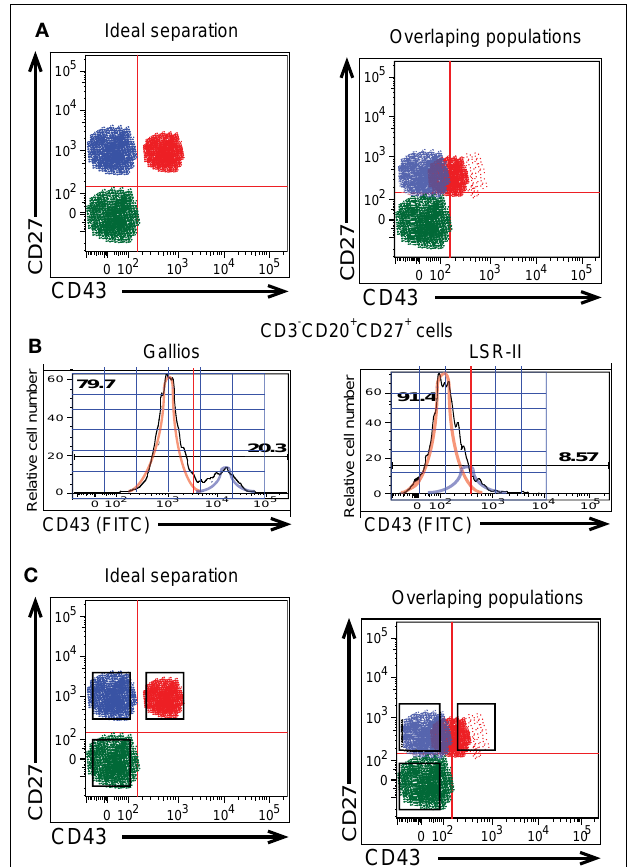
FIGURE 3 | Gating to distinguish positively and negatively stained B cells is difficult when populations overlap. (A) Diagrammatic models of ideal separation vs overlapping detection of CD43 + and CD43 − populations of CD27 + B cells are shown. (B) Adult peripheral blood mononuclear cells were immunofluorescently stained for CD20, CD27, CD43, and CD3, and were then evaluated by flow cytometric analysis. Expression of CD43 on CD3 − CD20 + CD27 + cells as detected by a BD LSR-II flow cytometer and a Beckman-Coulter Gallios flow cytometer on the same representative adult peripheral blood sample is displayed as a histogram along with idealized normal distribution curves. (C) Diagrammatic models of sorting gates applied to ideal separation vs overlapping detection of cell populations are